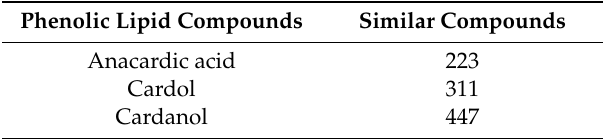
Table 1. The number of similar compounds retrieved from PubChem